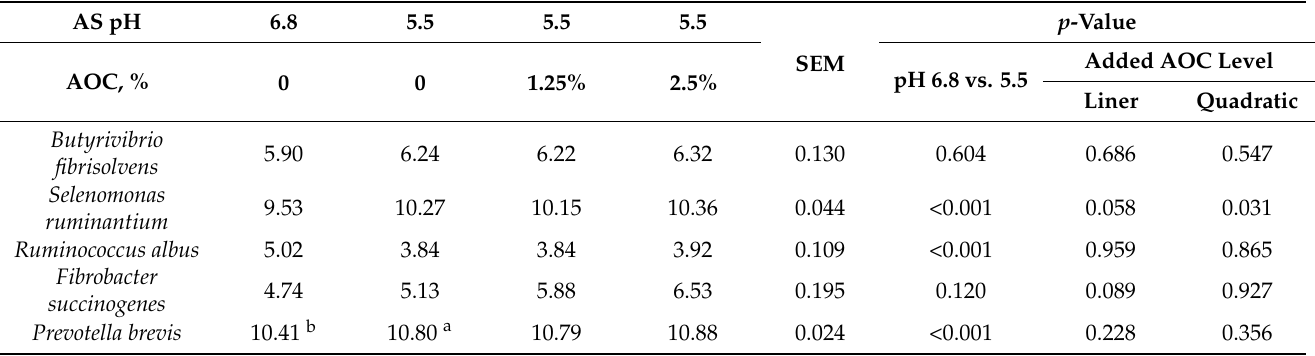
Table 5. The effect of AS pH and supplementation of AOC on rumen bacteria in RUSITEC system (Log10 16S rRNA copy number/mL rumen fluid).